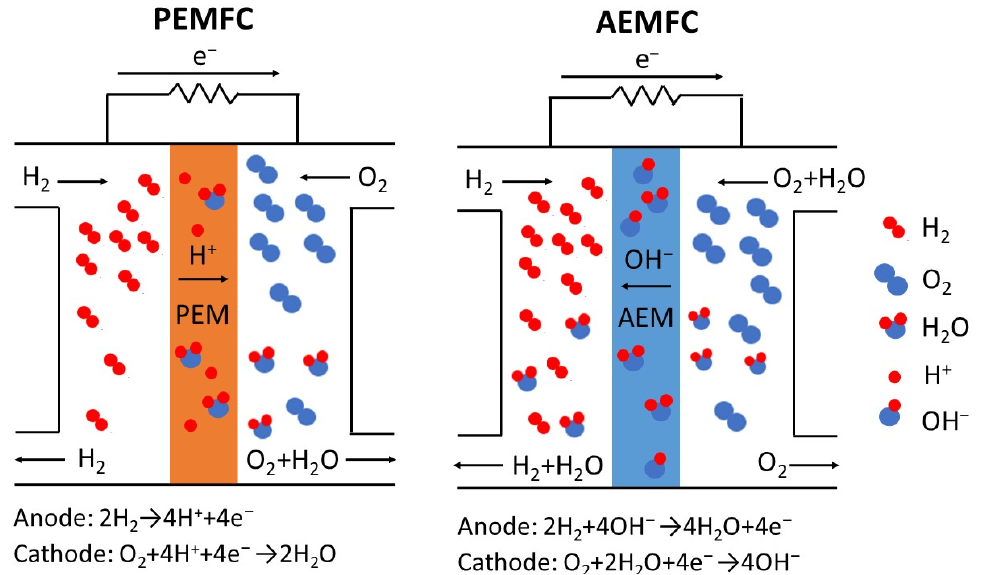
Figure 1. Schematic diagrams of a PEMFC and an AEMFC, with the relevant electrode reactions. For PEMFCs, the O 2 source is air. For AEMFCs pure O 2 or CO 2 -free air is used as the cathode feed.